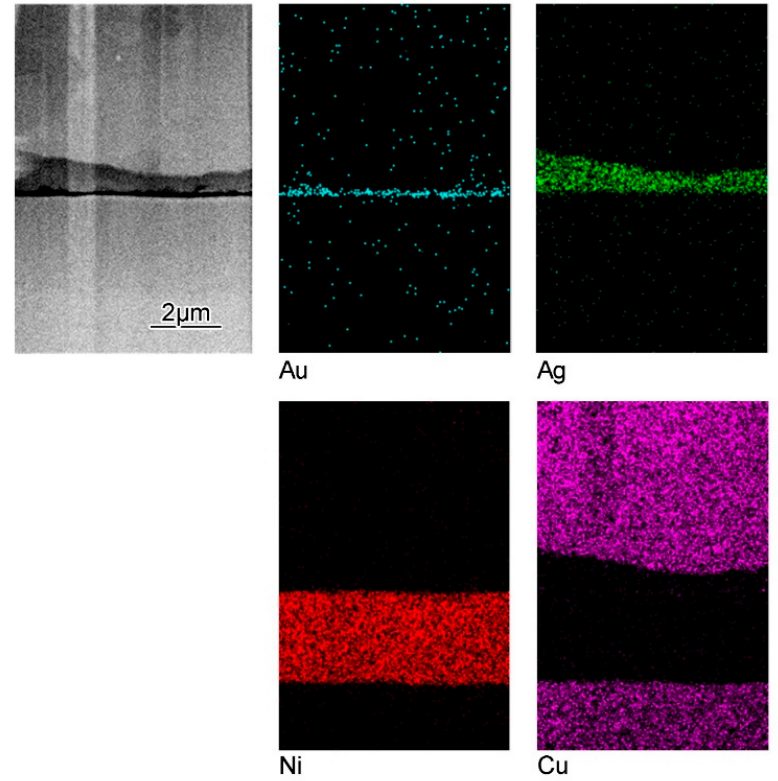
Figure 9. STEM image and EDS mapping of each element around the interface.